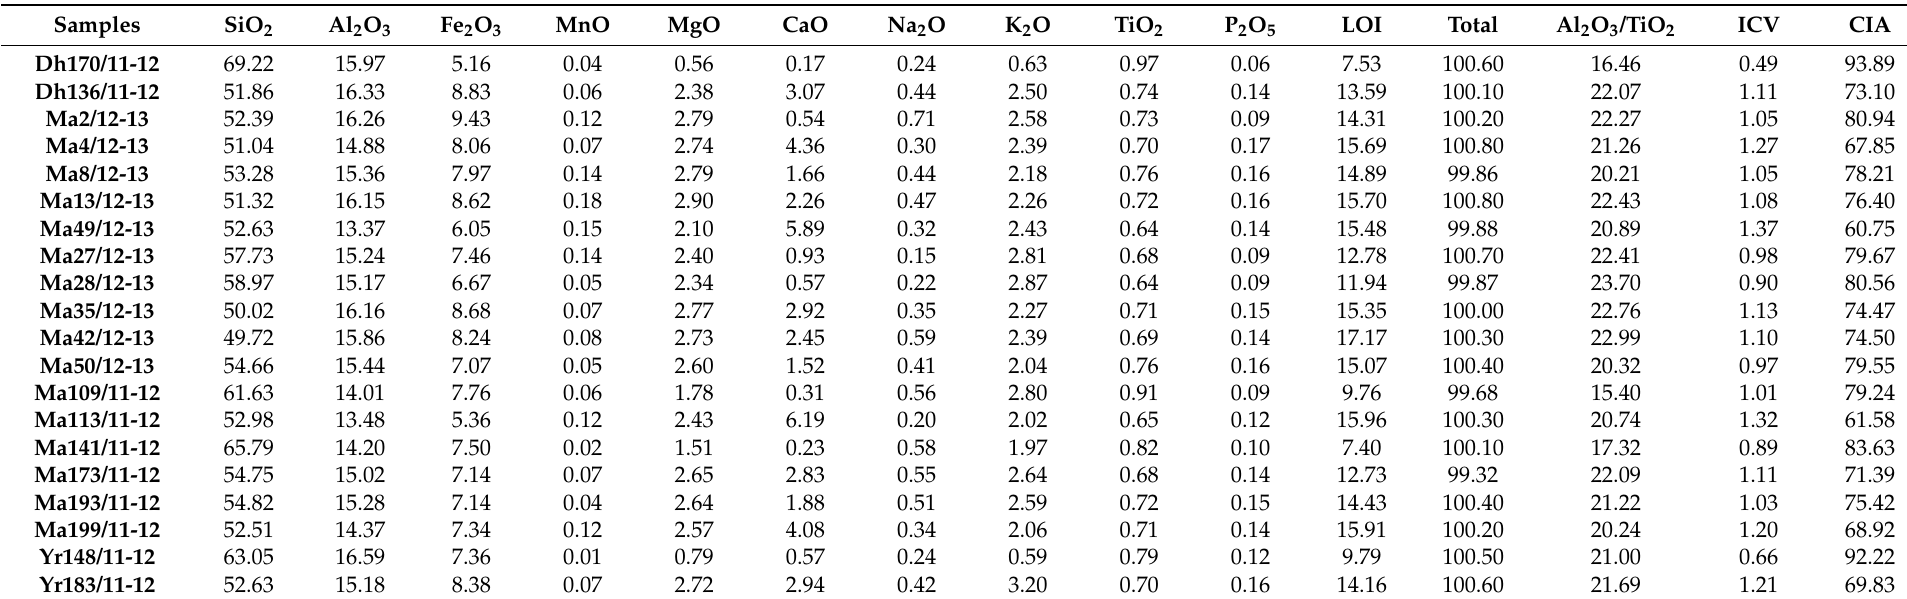
Table 4. Major oxide concentration (wt.%) in mudstone samples of the Yerrapalli, Maleri and Dharmaram